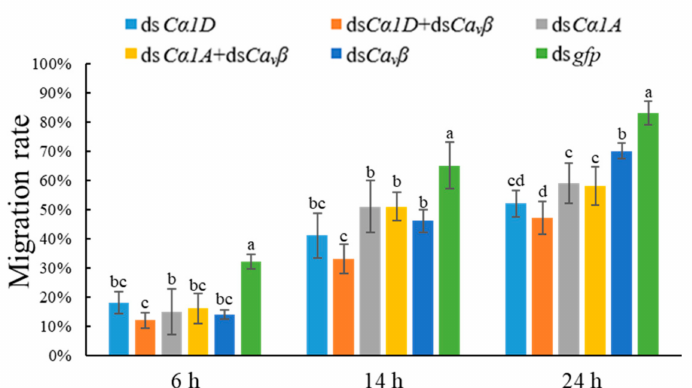
Figure 6. Silencing of Ca v β or HVA Ca v α 1 and co-silencing of Ca v β and HVA Ca v α 1 affected the locomotory activity of D. destructor . Nematodes that were treated with gfp dsRNA were used as controls. Different lowercase letters indicate a significant difference at the level of p < 0.05, as tested by Duncan’s new complex difference method.